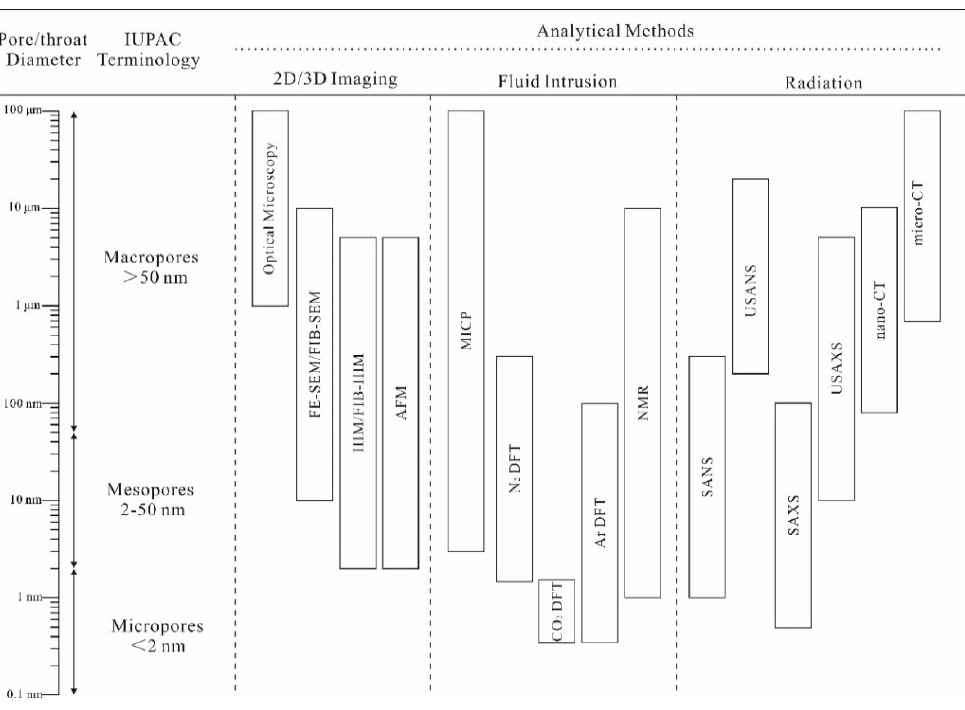
Figure 1. Methods used to investigate pore characteristics in shale (modified from [3]).